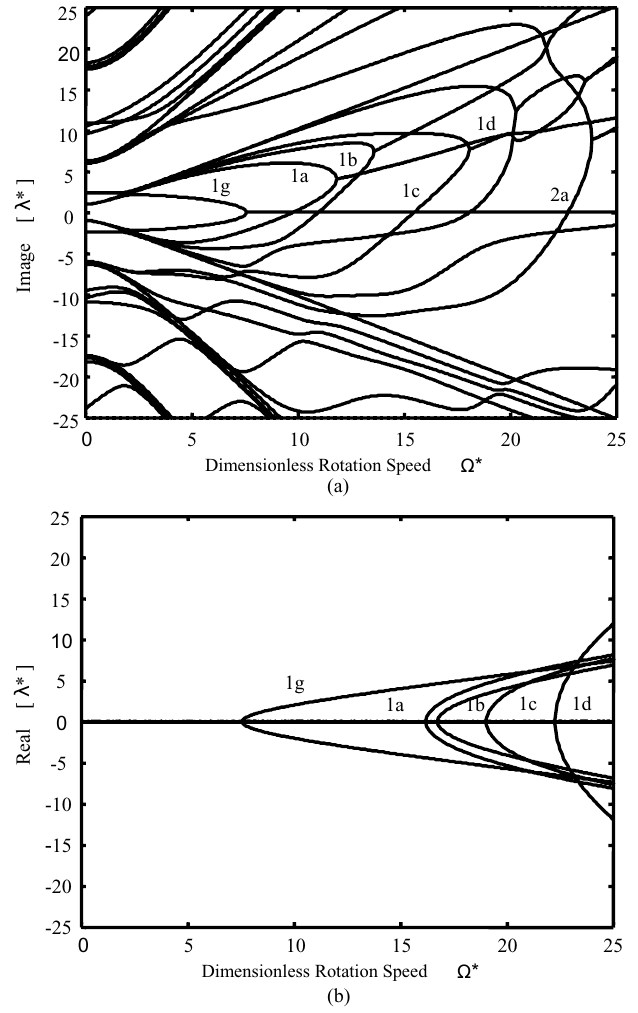
Fig. 9. Variation of eigenvalues with rotation speed for a well-tuned six-blade